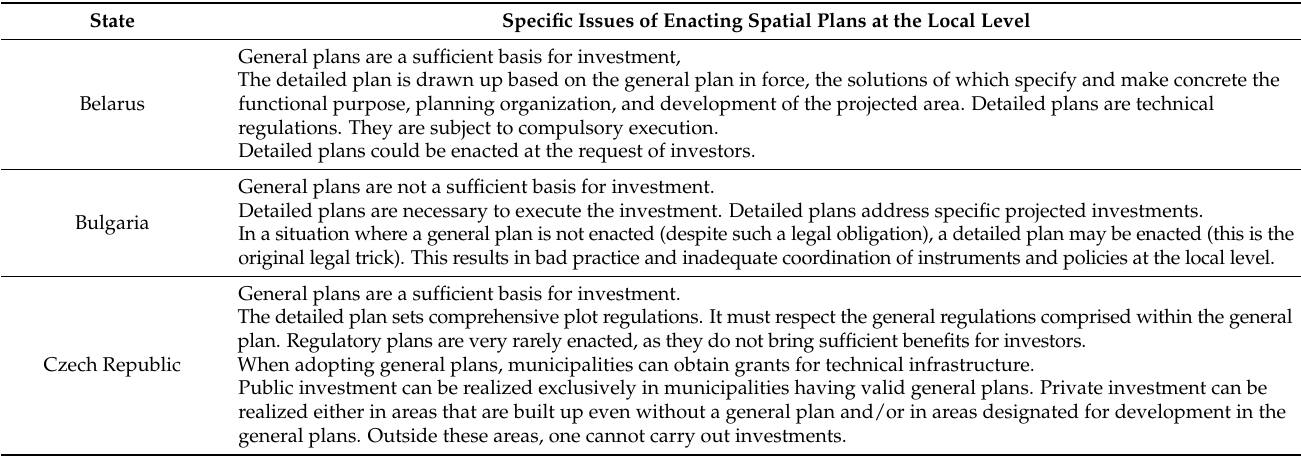
Table 4. Country-specific issues in determining the interdependencies and consequences of enacting spatial plans at the local